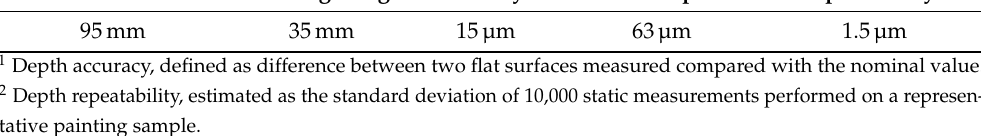
Table 2. Characteristic parameters of the conoscopic sensor ConoPoint-3 coupled to the 100 mm lens. Stand-Off Distance Working Range Accuracy 1 Laser Spot 95mm 35mm 15µm 63µm 1.5µm 1 Depth accuracy, defined as difference between two flat surfaces measured compared with the nominal value.